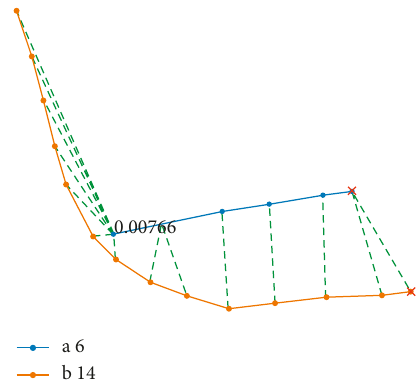
Figure 1: Spatial distribution and matched pairs diagram of DTW between two series a and b .